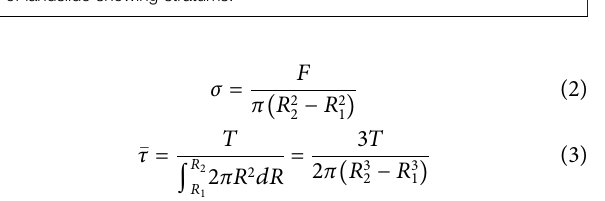
Frontiers in Earth Science |